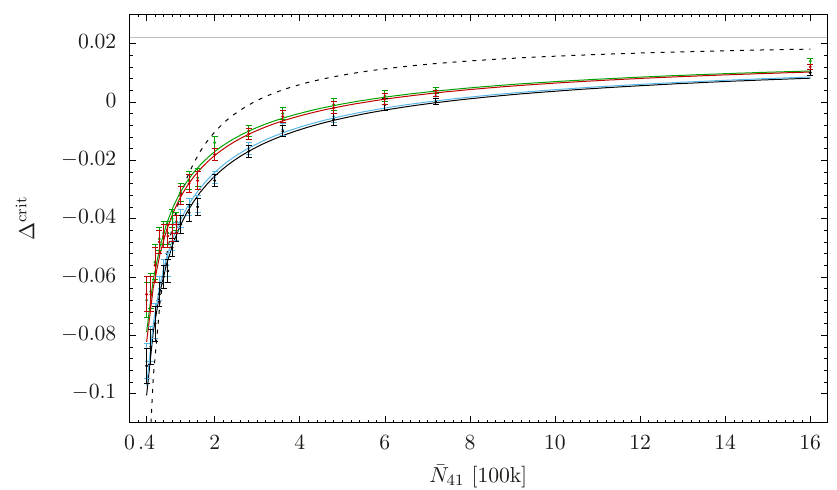
Figure 4 . The pseudo-critical value (cid:1) crit as a function of (cid:22) N 41 . The solid lines are (one parameter) (cid:12)ts of formula (2.2) with (cid:12)xed common values of (cid:13) = 1 : 64 and (cid:1) crit ( follow the convention used in (cid:12)gure